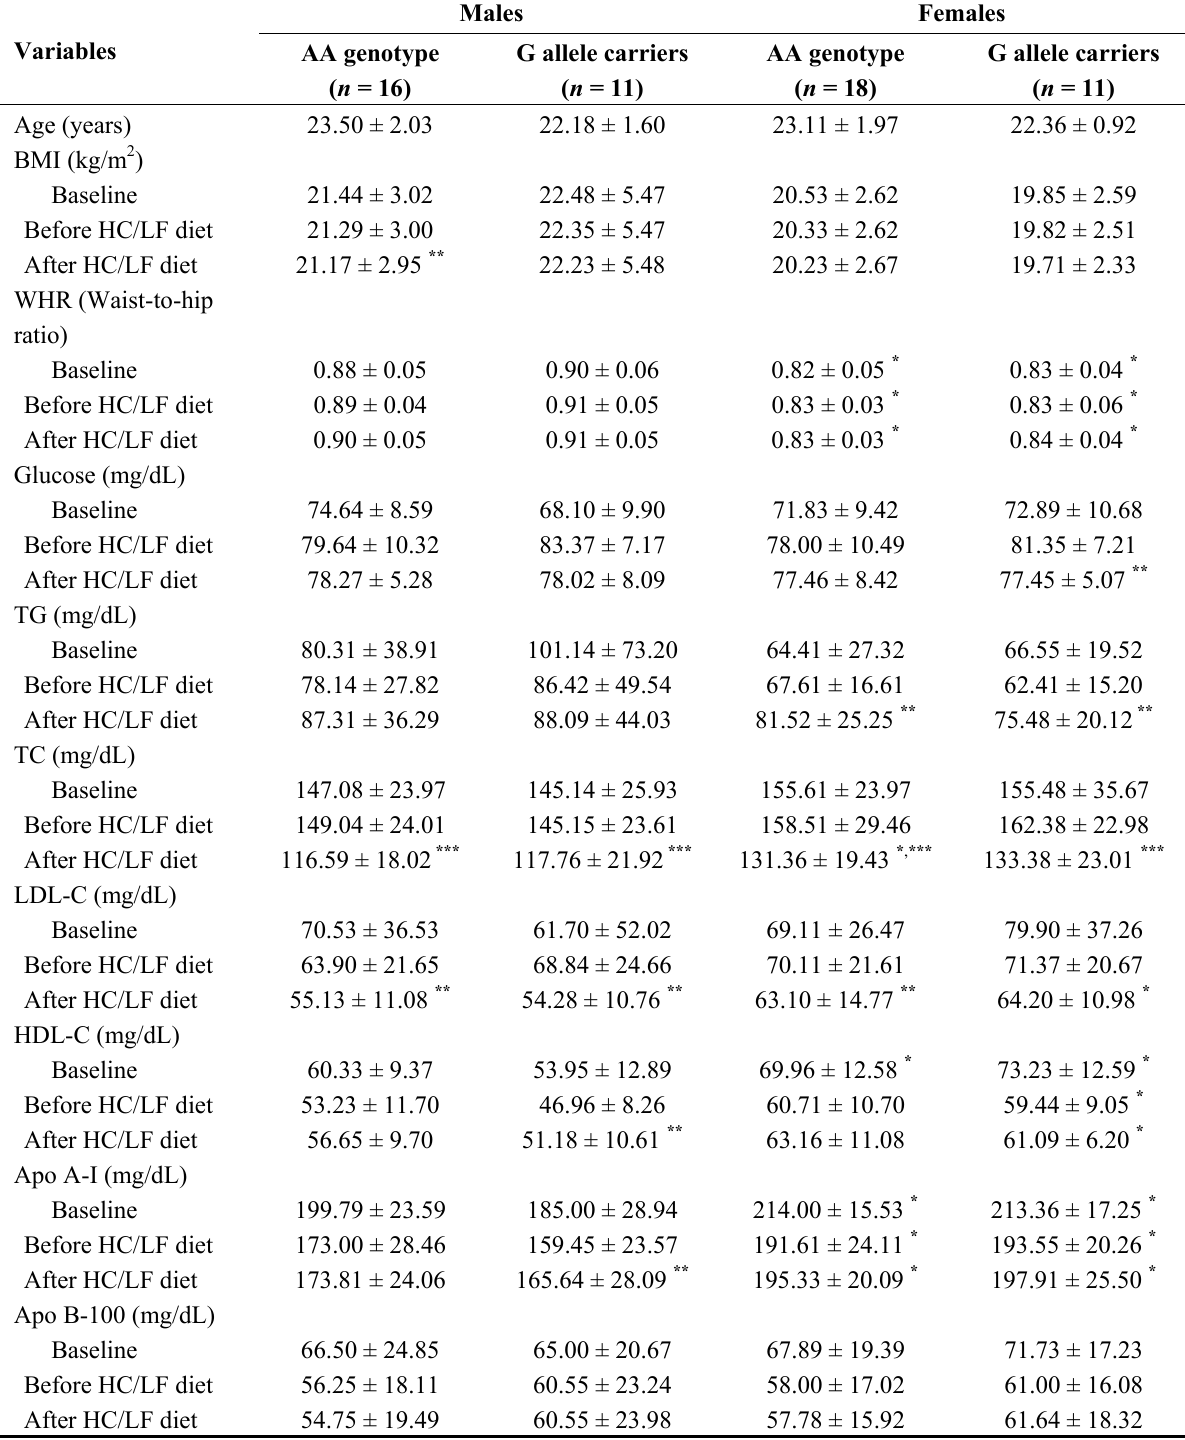
Table 4. Anthropometric parameters, glucose, lipids and apolipoproteins of the male and female subjects with different LPL rs326 genotypes at baseline and before and after the HC/LF